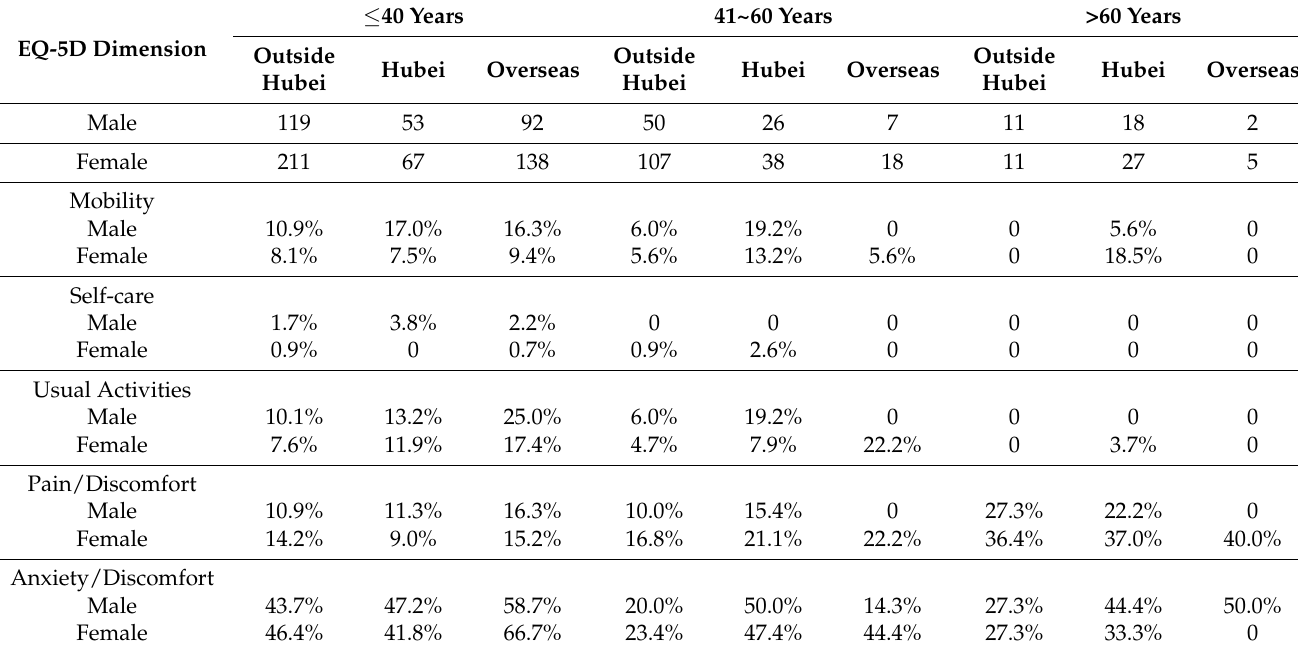
Table 2. Percentage of respondents reporting any problems in each EQ-5D dimension, by age group, gender, and region.